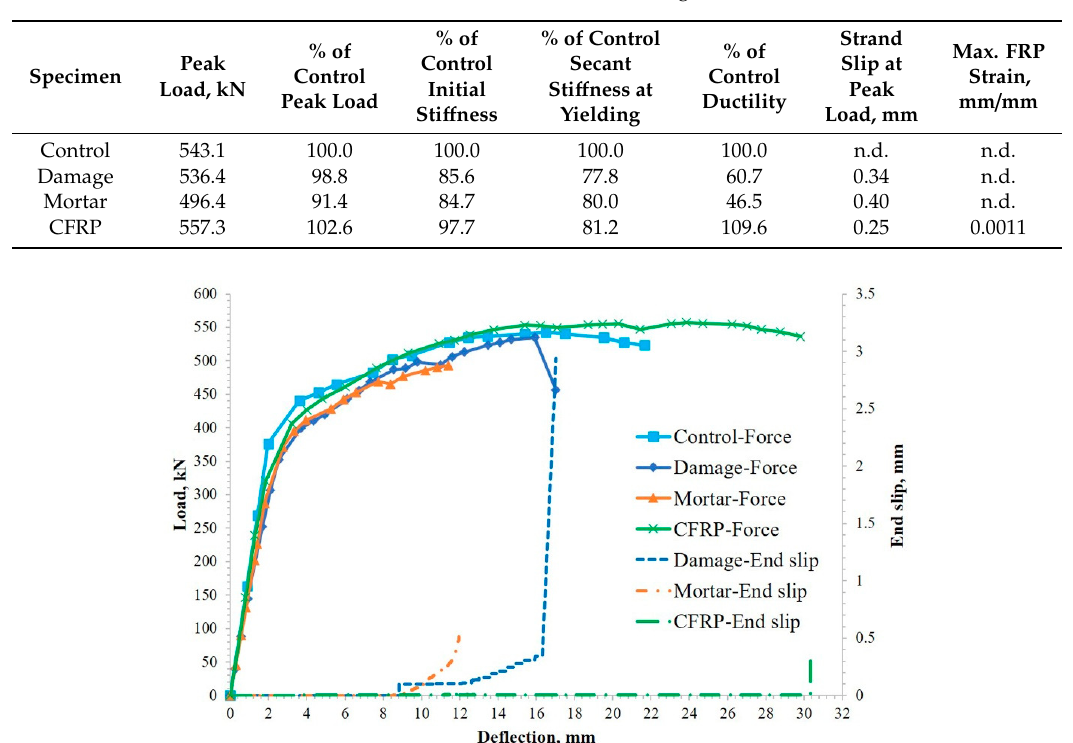
Table 2. Test results of full-scale PC girders.